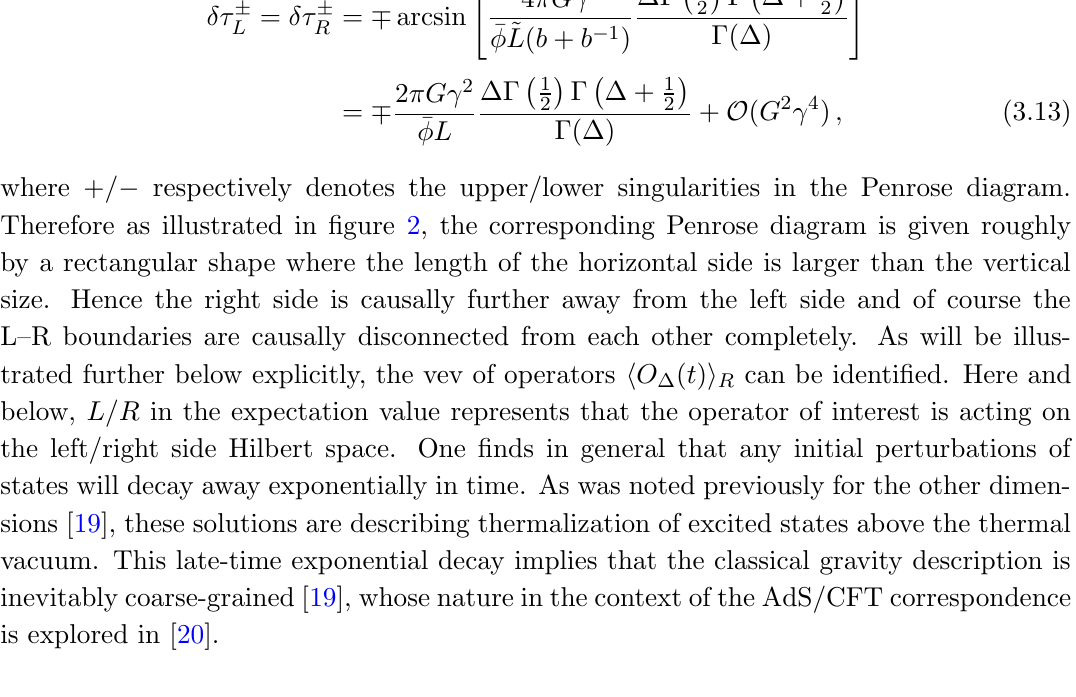
JHEP08(2018)140